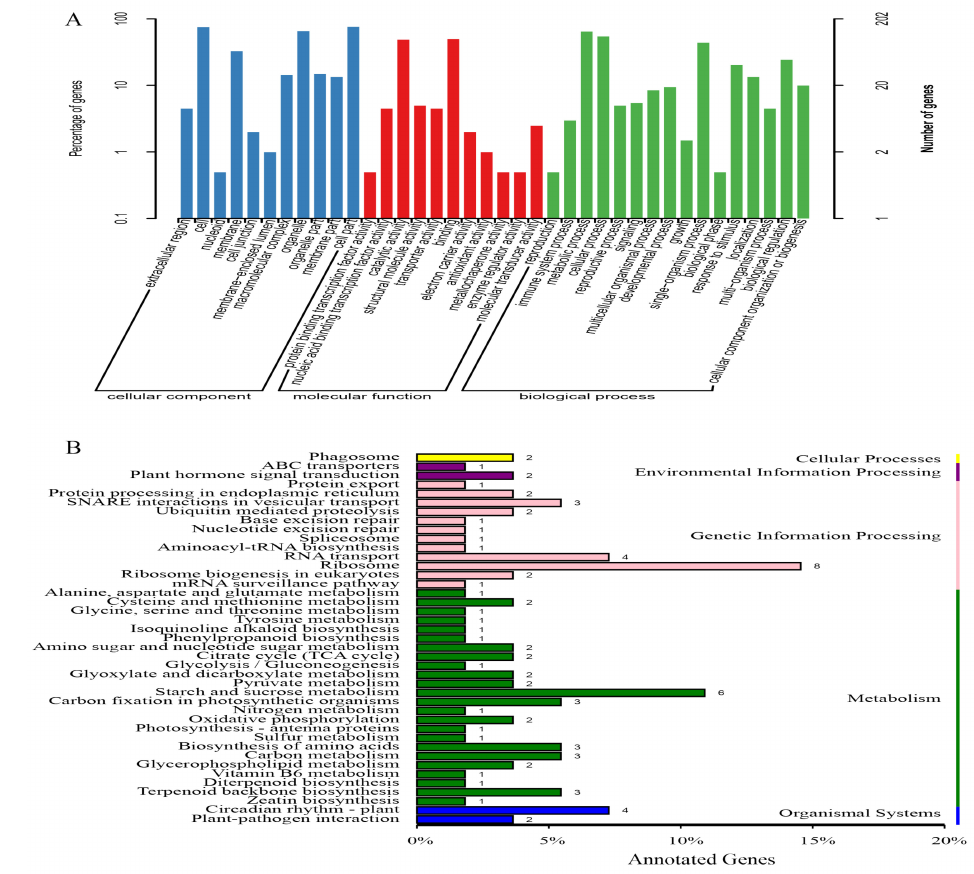
Figure 4. Enrichment analysis of candidate genes in sugarcane brown stripe (SBS) resistance- associated regions. ( A ) GO functional enrichment analysis. ( B ) KEGG pathway enrichment analysis.